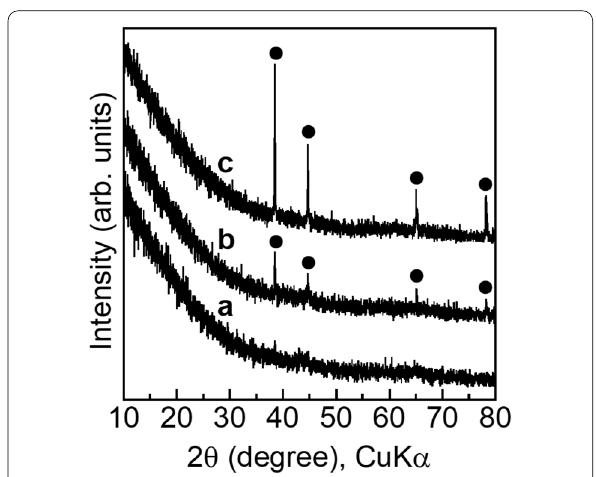
Fig. 4 XRD patterns for nanoparticles in colloidal solutions prepared by electrolysis at a 25 °C, b 35 °C, and c 45 °C. ● : cubic